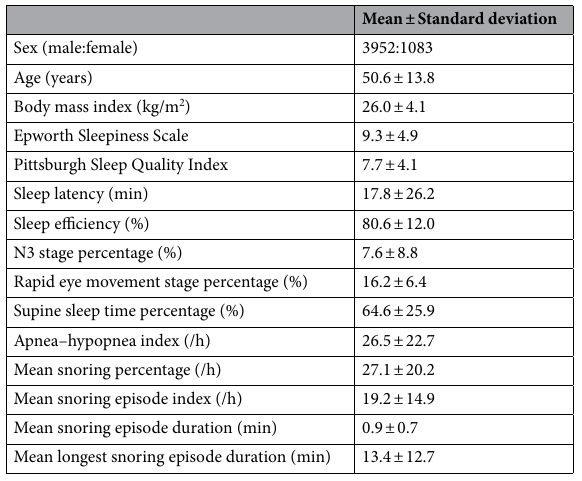
Table 1. General and polysomnographic characteristics of the